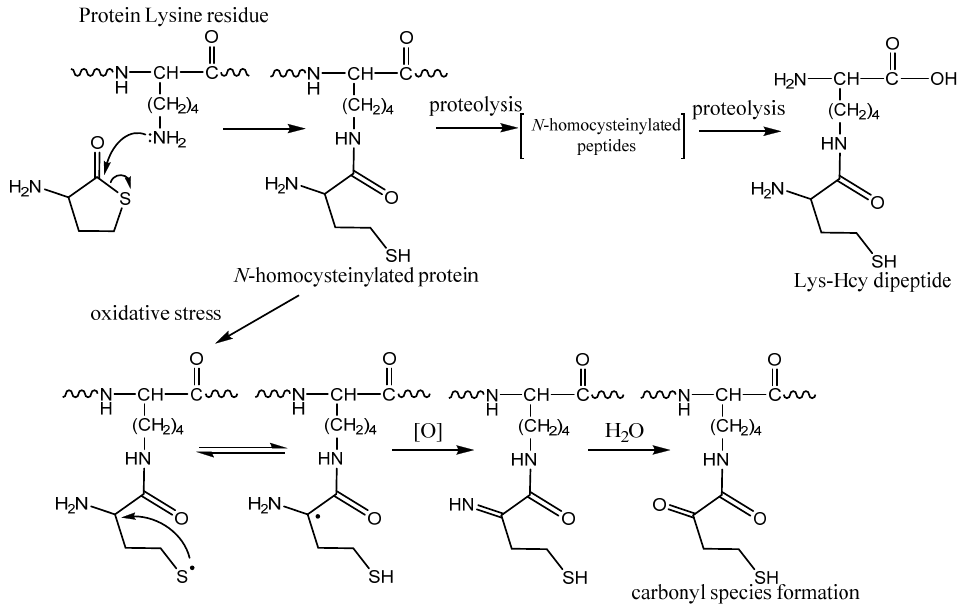
Figure 4. Protein N -homocysteinylation: chemical modification of a lysine residue by homocysteine thiolactone (HTL). Formation of dipeptide N ε -Hcy-Lys by protein proteolysis. The mechanism of carbonyl species formation by N -homocysteinylated proteins caused by oxidative stress.